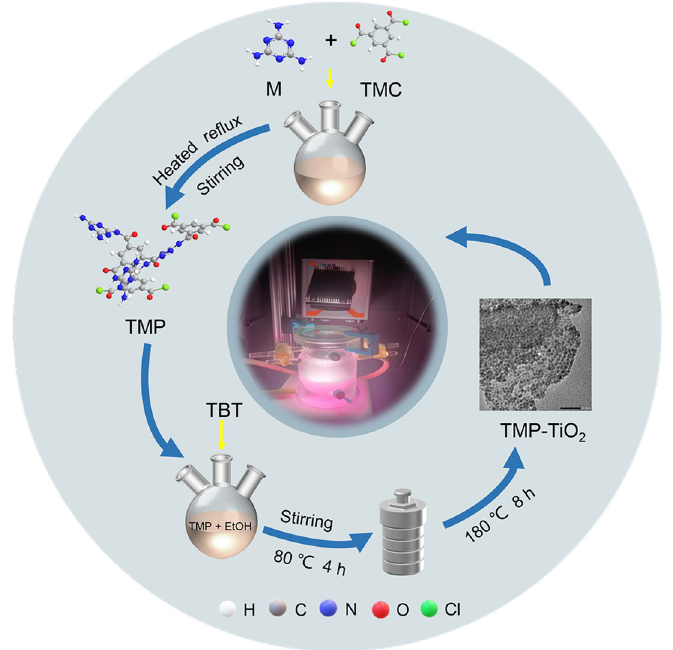
Figure 1. Flow diagram of the material preparation.